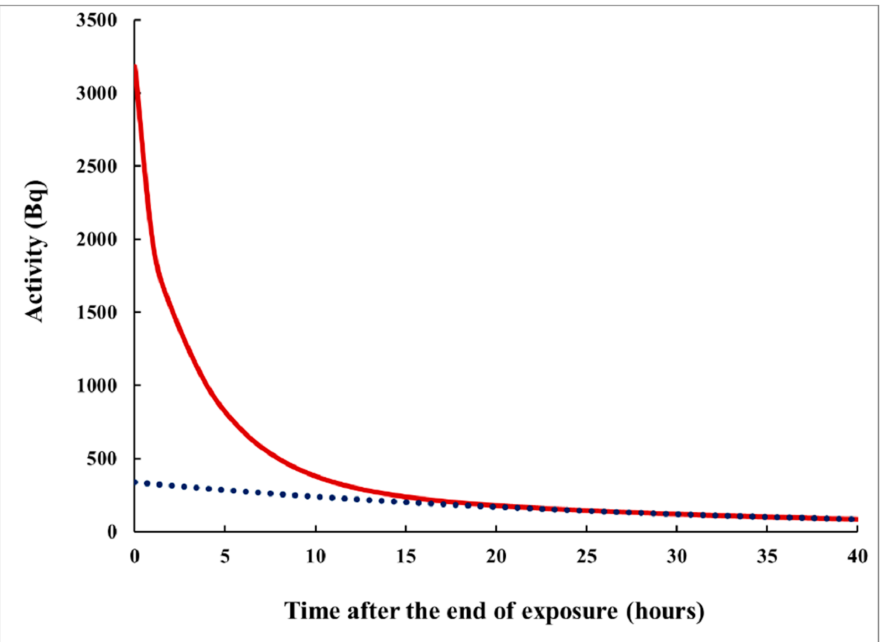
Figure 3. The decrease in the activity in the specimen (due to radioactive decay and outgazing) after the end of exposure, according to eqn. (6). The initial activity of the specimen (at the end of exposure) is 3200 Bq. The dotted line corresponds to the “slowest component” in the sum (6), ( 2 ) T ). Note that the ratio A ( τ )/ A ( t+ τ ) at fixed t depends on τ ; therefore, τ might be that is ~exp( − λ 1 correlated with S 1 / S 2